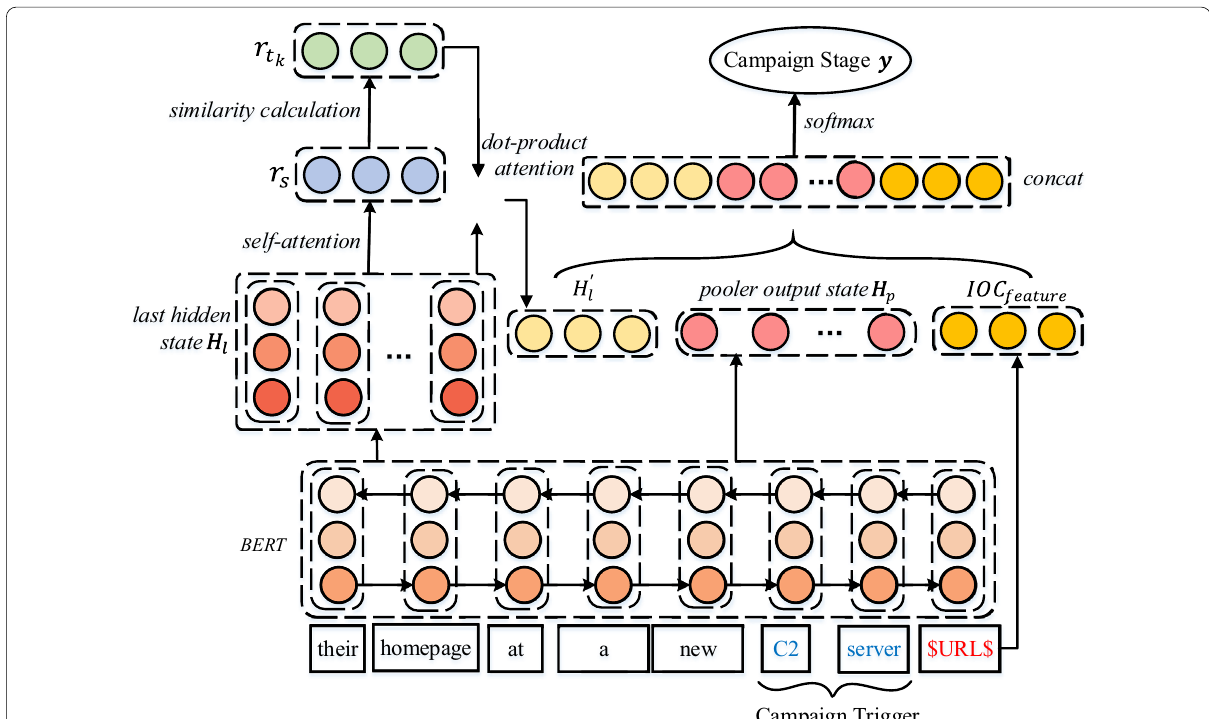
is the most similar trigger vector to final sentence k